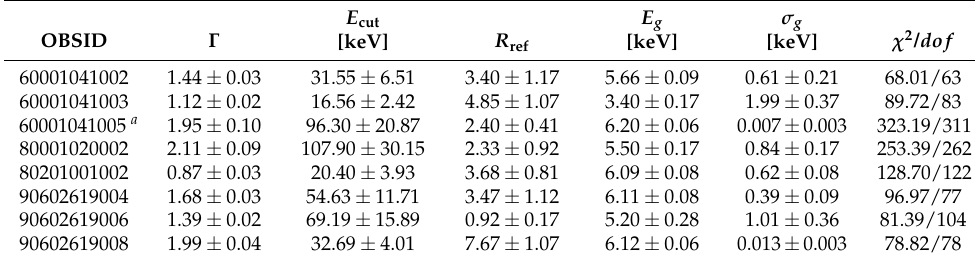
Table 3. Best-fitting parameters with the TBABS ( PEXRAV + GAUSS ) model.